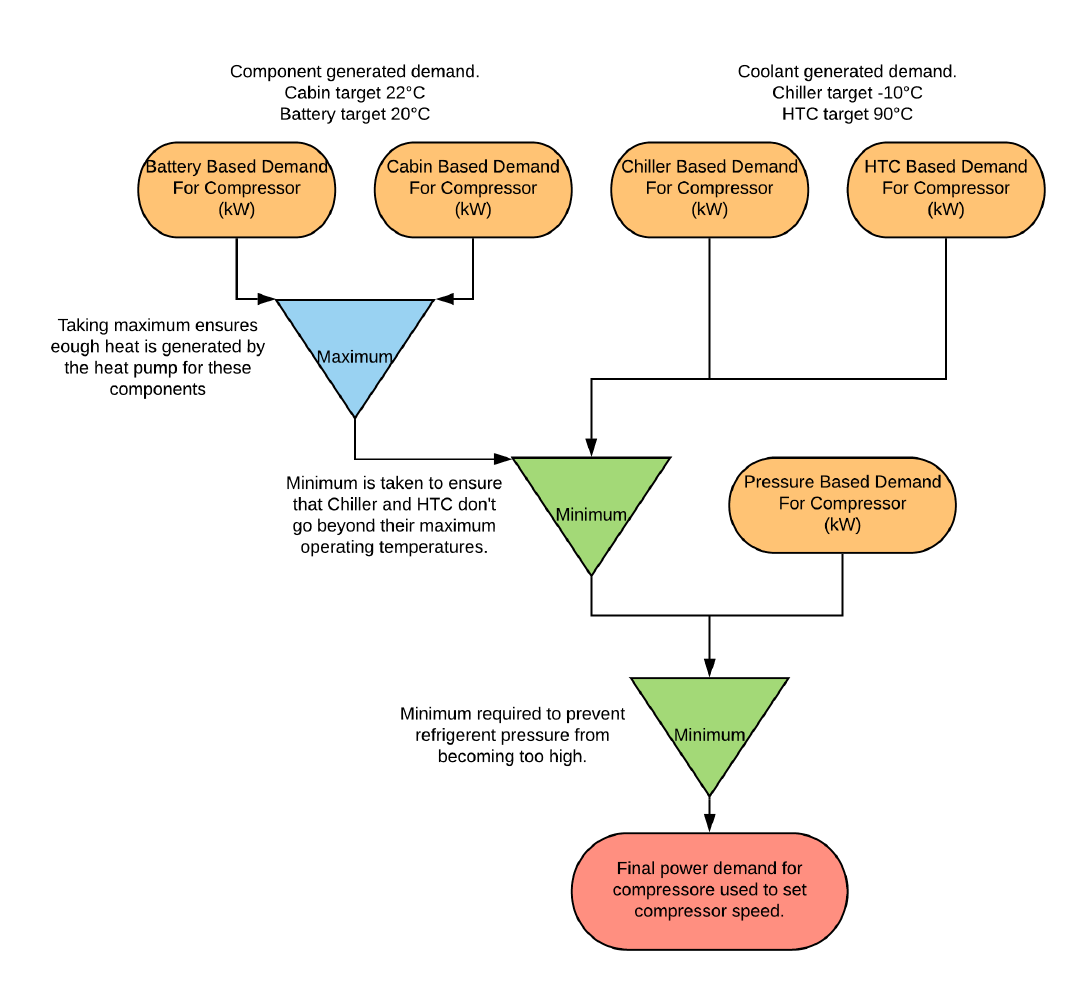
Figure 7. A flow chart showing how the compressor is